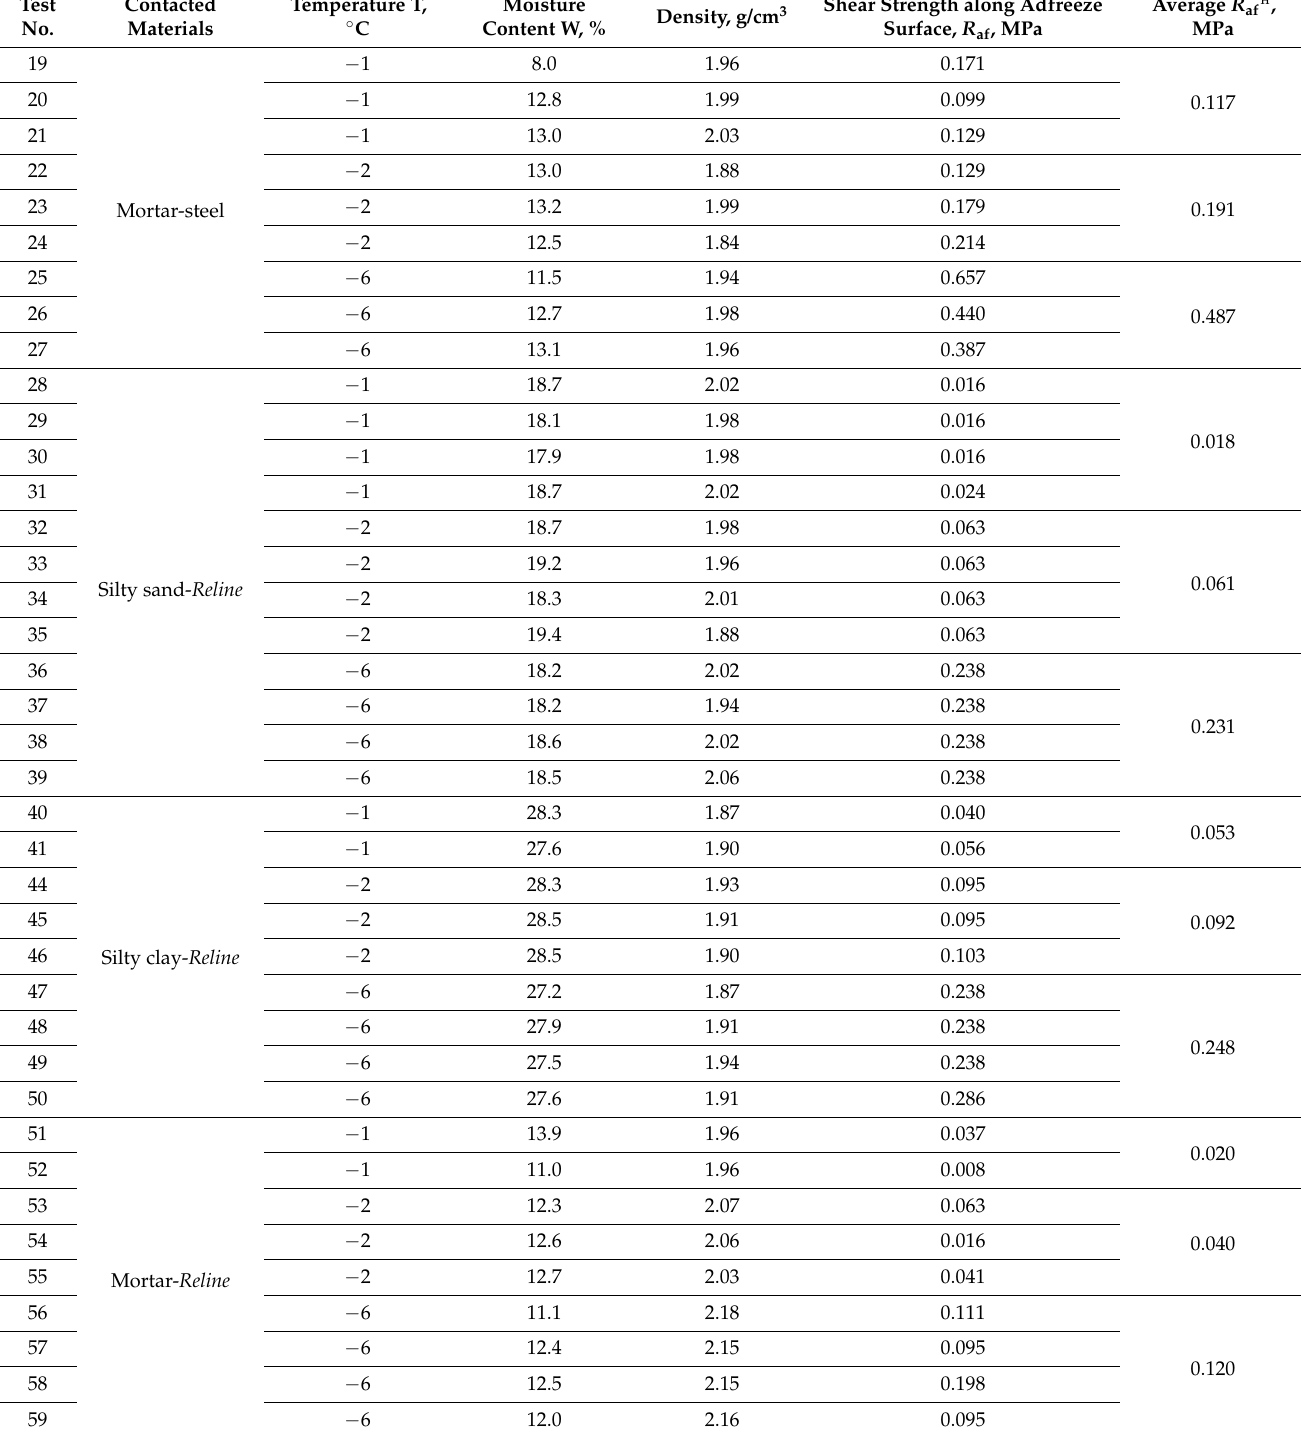
as reference for further testing. Another series of tests was with samples in the Reline